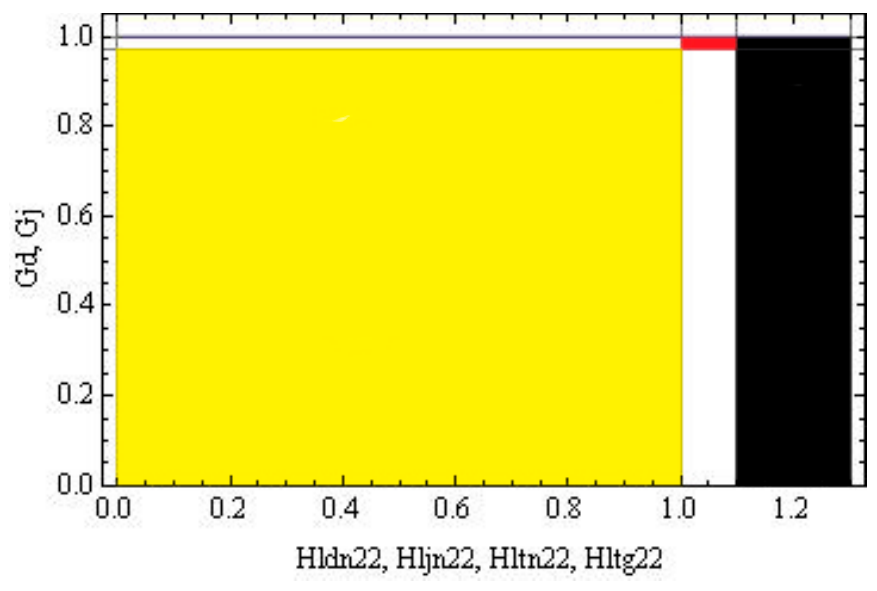
Figure A1. Characterization of a randomly chosen author for life sciences. Black area (17.1%) = networking; red area (0.9%) = intradisciplinary and intratopical heterodox; yellow area (48.7%) = intradisciplinary and intertopic orthodox; blue area (3.6%) = interdisciplinary and intertopical orthodox. G d = 0.22, G j = 0.93, H ldn = 0.23, H ljn = 1.17, H ltn = 1.37, H ltg = 1.65. Abbreviations: G d , Gini index for disciplines; G j , Gini index for journals; H , Hirsch indexes; d = discipline, g = gross, j = journal, l = linear, n = net, t = total.